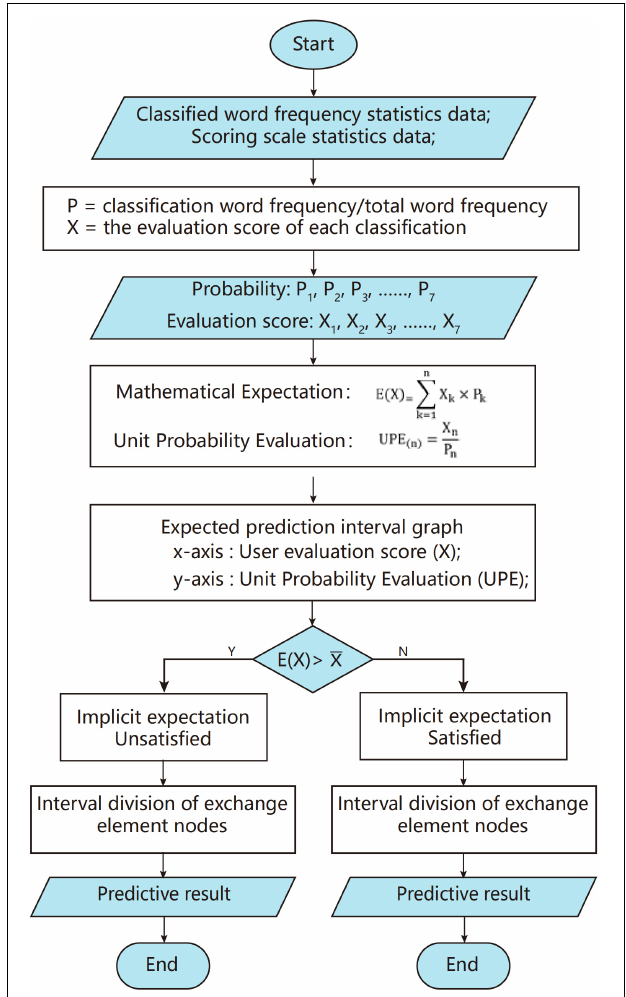
FIGURE 5 | Expectation predictive